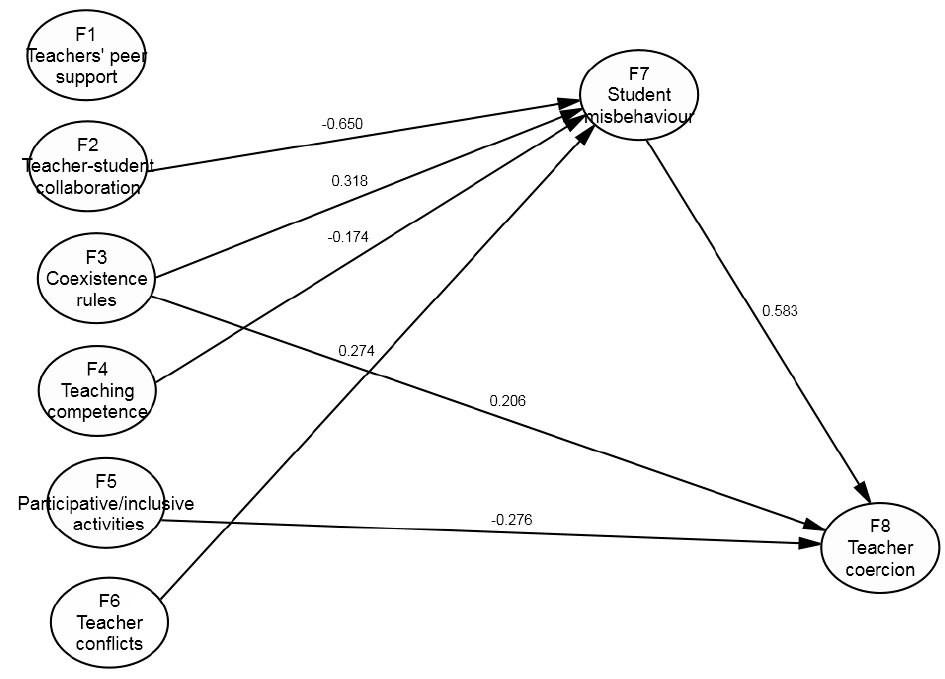
Figure 3. Results for secondary school teachers.